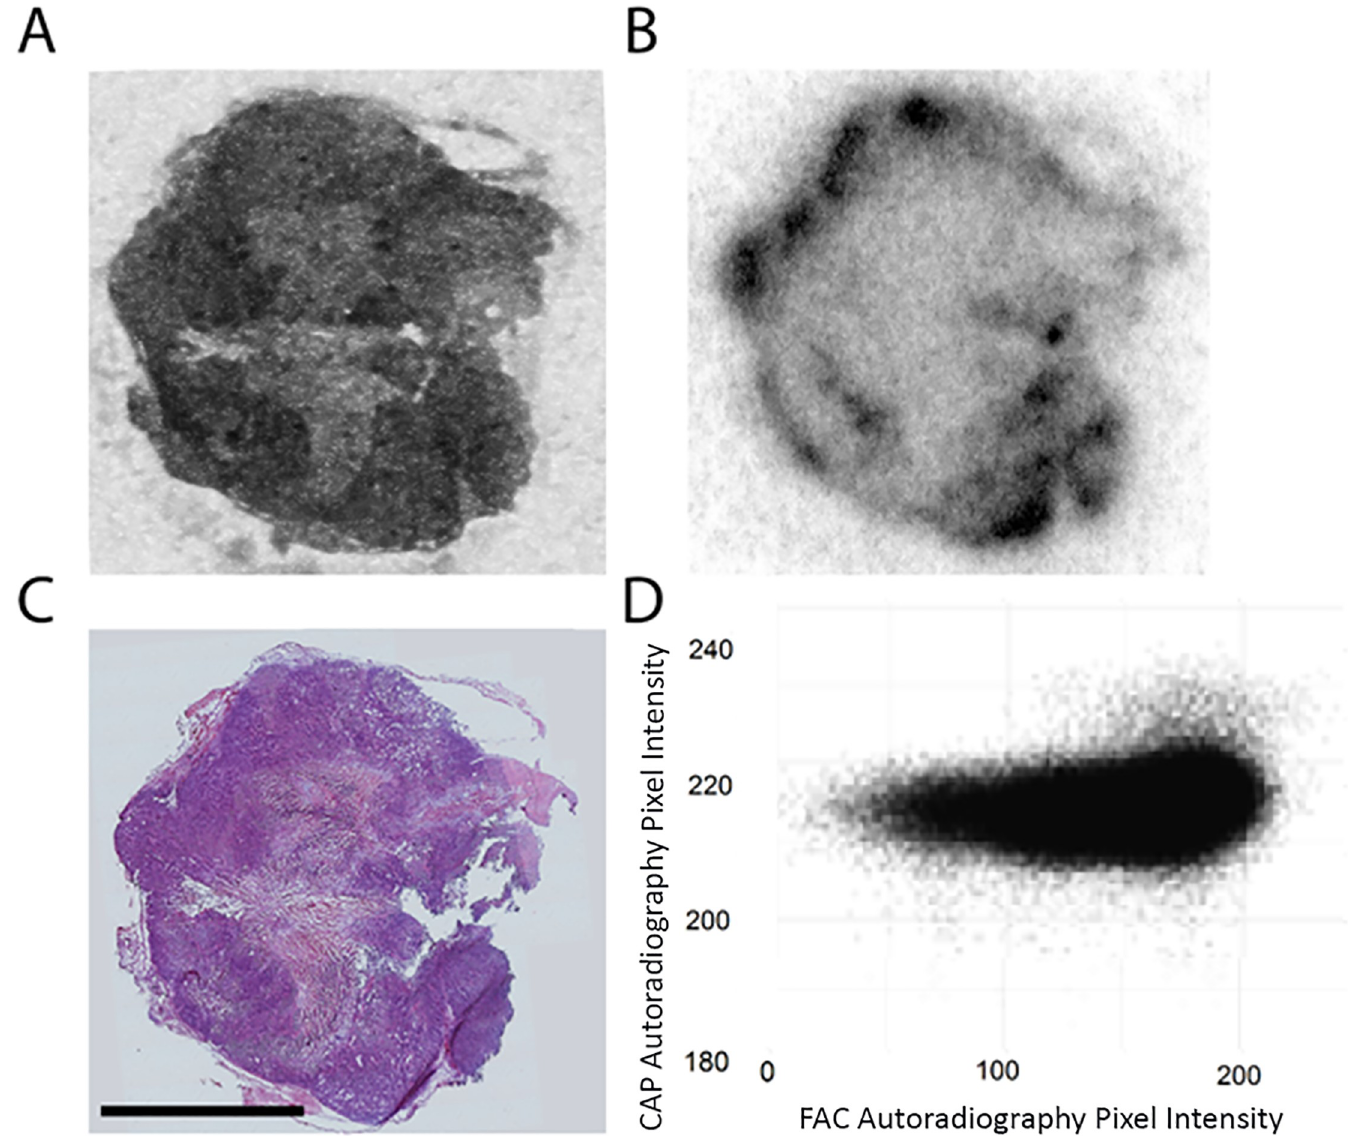
Fig 5. Capecitabine and FAC intra-tumoral distribution. Autoradiography of [ 3 H]-capecitabine (A) and of [ 18 F]-FAC (B) in an organoid tumor section. H&E staining of that tumor section (C). Scale bar = 5mm. Scatter plot of the pixel-to-pixel comparison for [ 18 F]-FAC and [ 3 H]-capecitabine autoradiography signal (D).